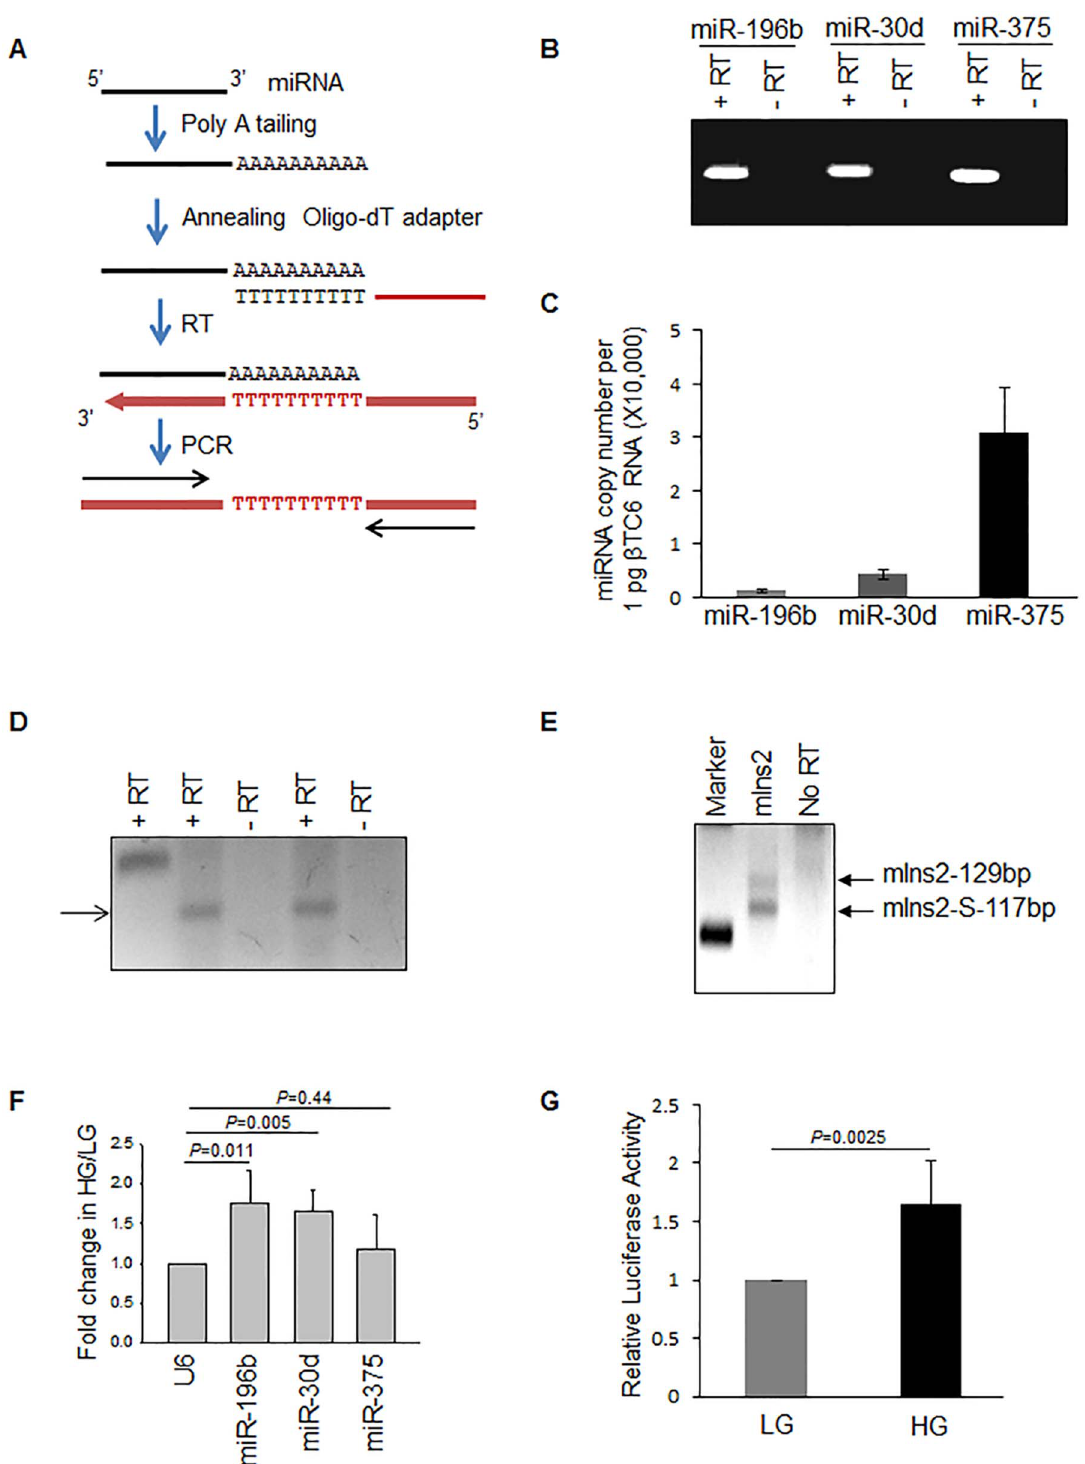
Figure 5. Expression of miR-196b. ( A ) Schematic of the method used for miRNA RT-PCR using QuantiMiR kit (SBI). ( B ) The cDNA for miRNA RT- PCR was prepared from 1 m g of total RNA from b TC6 cells using QuantiMiR RT kit as per the manufacturer protocol. The upper panel shows the average absolute values calculated from Ct values of RT-qPCR of miRNAs amplified using universal reverse primer from the QuantiMiR kit and specific forward primers for respective miRNAs. The lower panel shows the miRNA RT-PCR or No RT-PCR products were resolved on a 3.5% agarose gel. ( C ) Comparison of miR-196b, miR-30d, and miR-375 expression from RT-qPCR data of b TC6 total. Copy numbers per 1 pg of total RNA were calculated using standard curve based on known amount of miRNA. ( D ) cDNA for miR-196b was prepared by miR-196b-RT stem-loop primer and amplified with specific primers (primers 18 and 20, Table S1). The cDNA for miR-375 was prepared by miR-375-RT stem-loop primer and amplified with specific primers (primers 19 and 20, Table S1) from e14.5 day pancreas and the PCR product was resolved on a 3.5% agarose gel. ( E ) Insulin2 RT-PCR detection